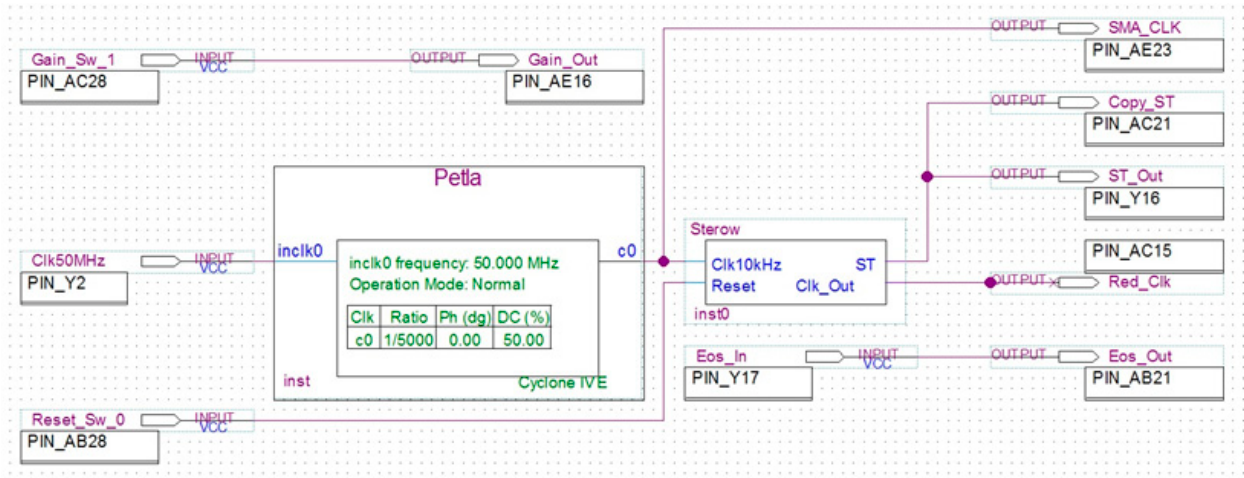
Figure 18. Simulation results of low-pass filter amplitude characteristics.